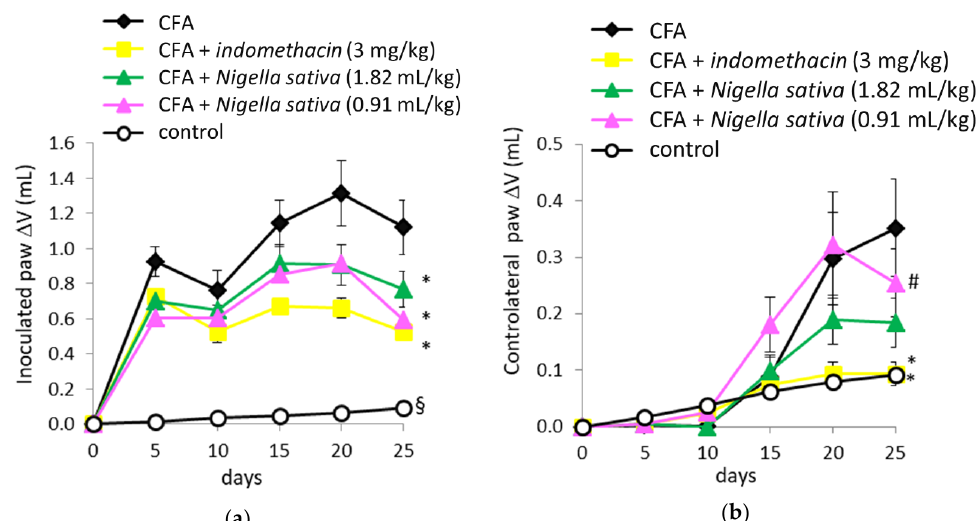
Figure3. E ff ect of Nigella sativa oil ondisease progression in CFA-induced arthriticrats. CFA-immunized rats (on day 0) received Nigella sativa oil (1.82 or 0.91 mL / kg), indomethacin (3 mg / kg) or vehicle by gastric gavage daily for 25 days. A group of non-immunized rats receiving vehicle during the same ( b ) paws was performed prior to the immunization, on day 0, and up to 25 days. Data expressed